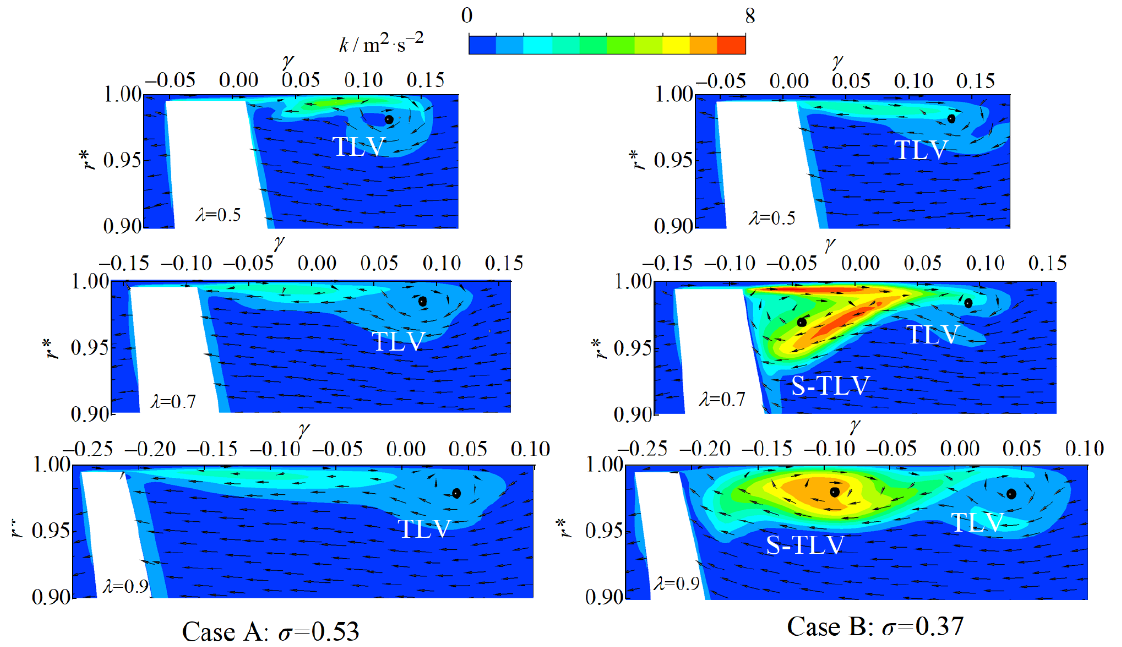
Figure 18. Distributions of TKE on three planes.